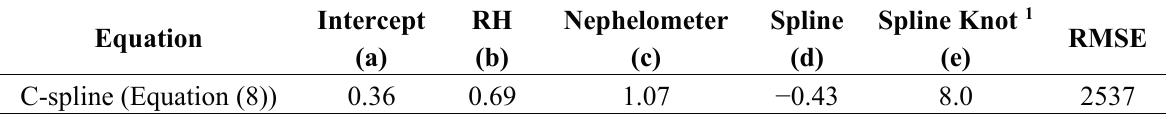
Table A1. Update of coefficients and RMSE on combined spline adjustment approach.